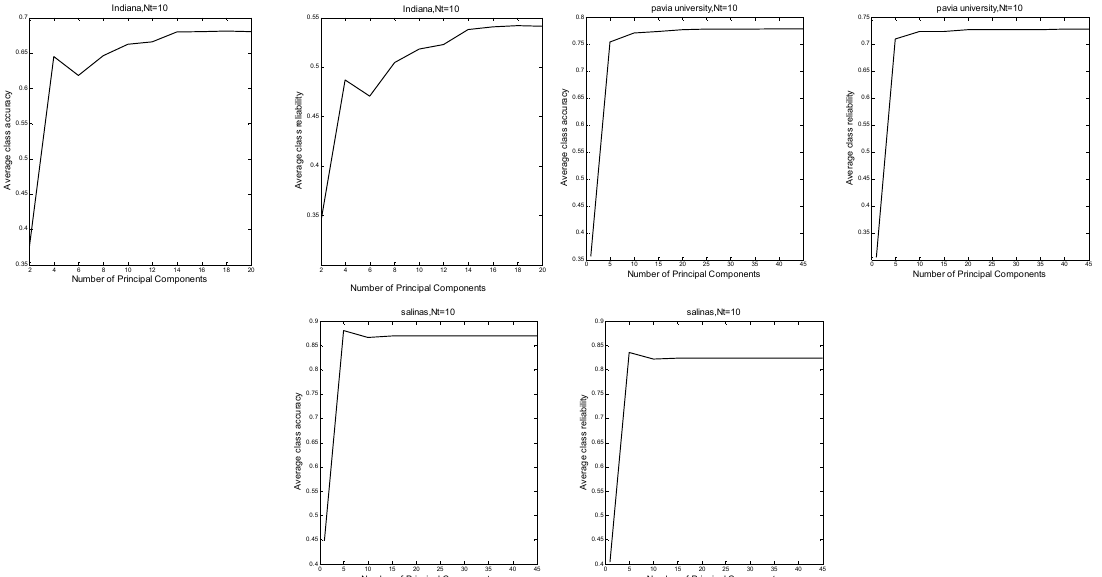
Figure 3. The average class accuracy and average reliability accuracy versus the number of principal components